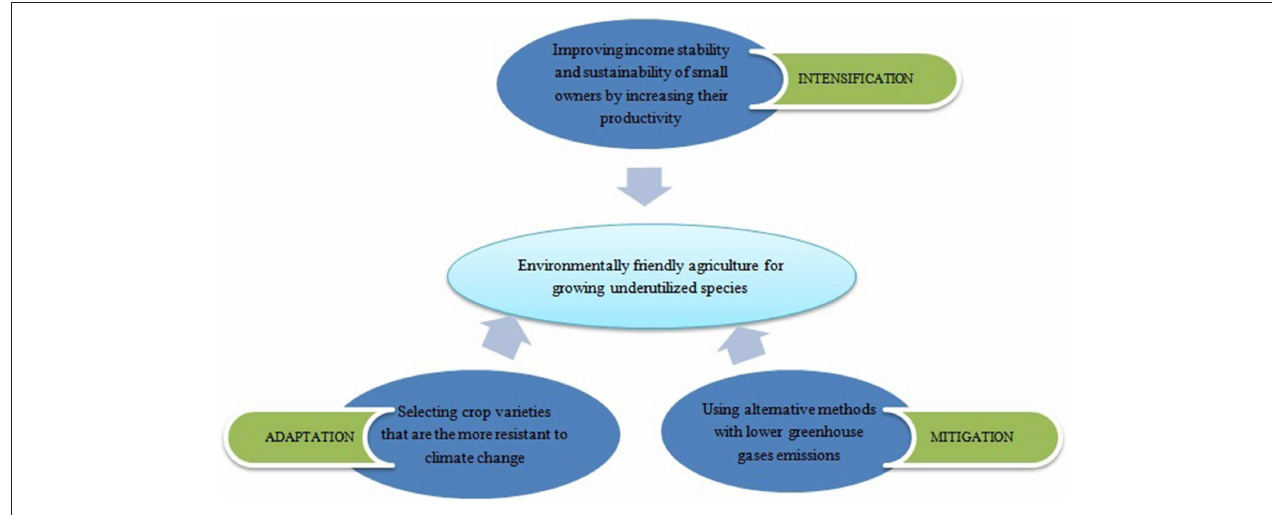
FIGURE 2 | Strategies to use underutilized species and increase the crops biodiversification for a sustainable agriculture [adapted from